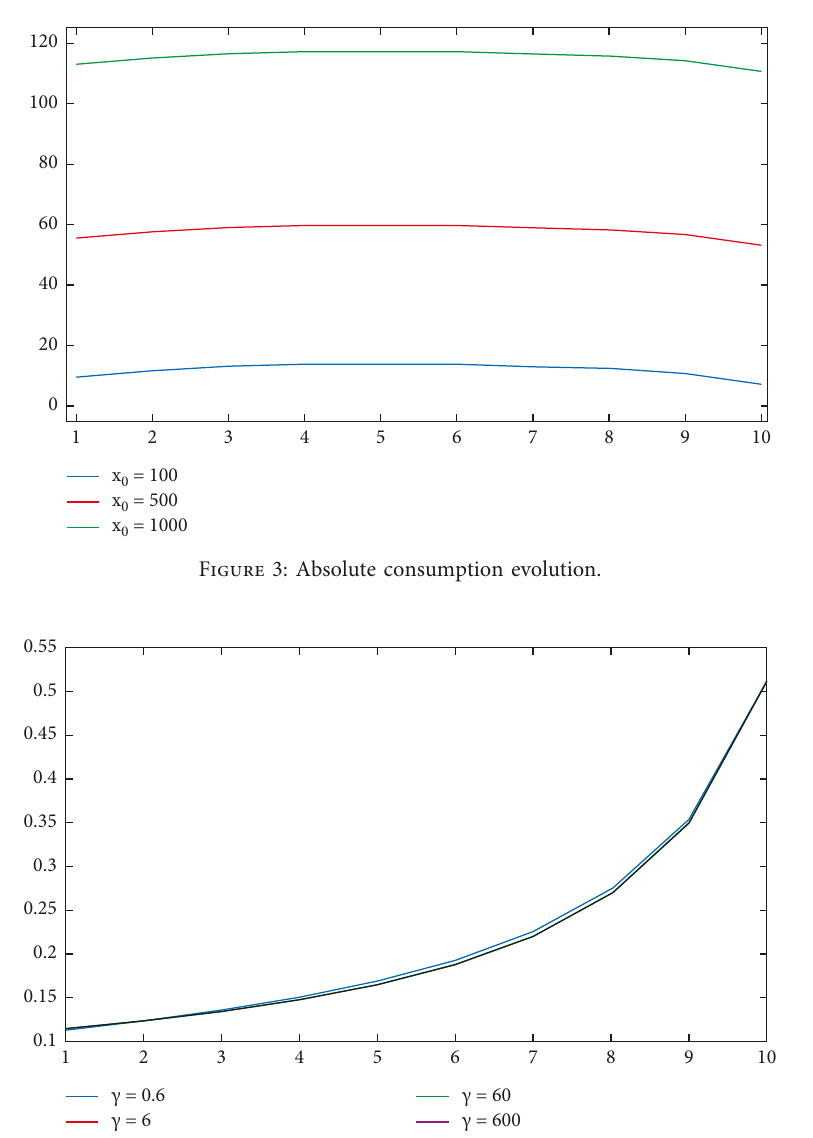
Figure 4: Relative consumption evolution by varying c .